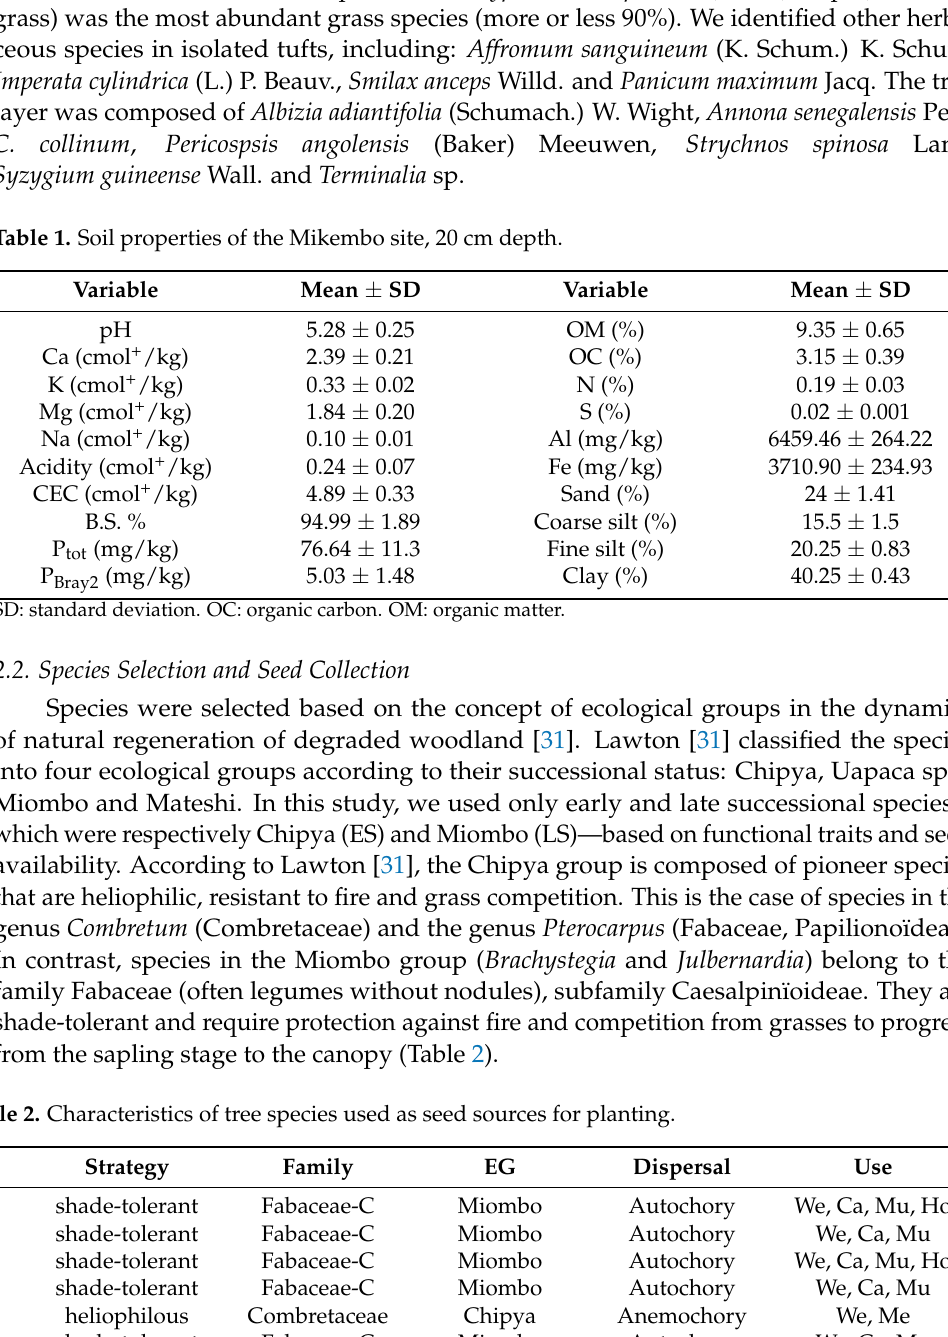
We, Ca, Mu We, Me We, Ca,